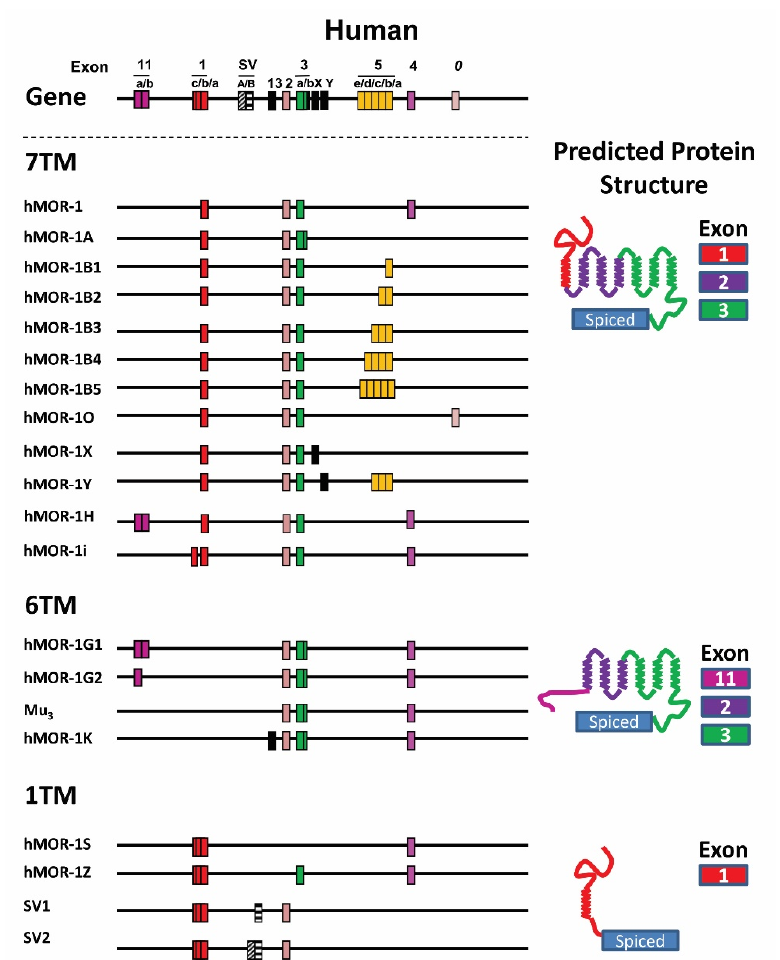
Figure 1. Schematic of the human OPRM1 gene structure and alternative splicing. The top panel is the OPRM1 gene structure. Alternatively spliced variants reported in the literature are grouped as 7TM, 6TM, and 1TM with predicted protein structure shown to the right and exon color coded to match the splicing schematic. From Pasternak and Pan 2013 [12] .